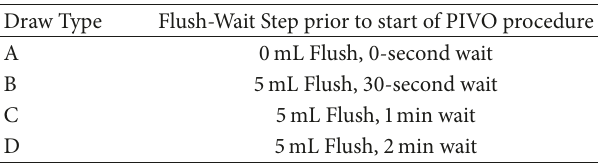
Table 1: Draw type and wait times. Draw